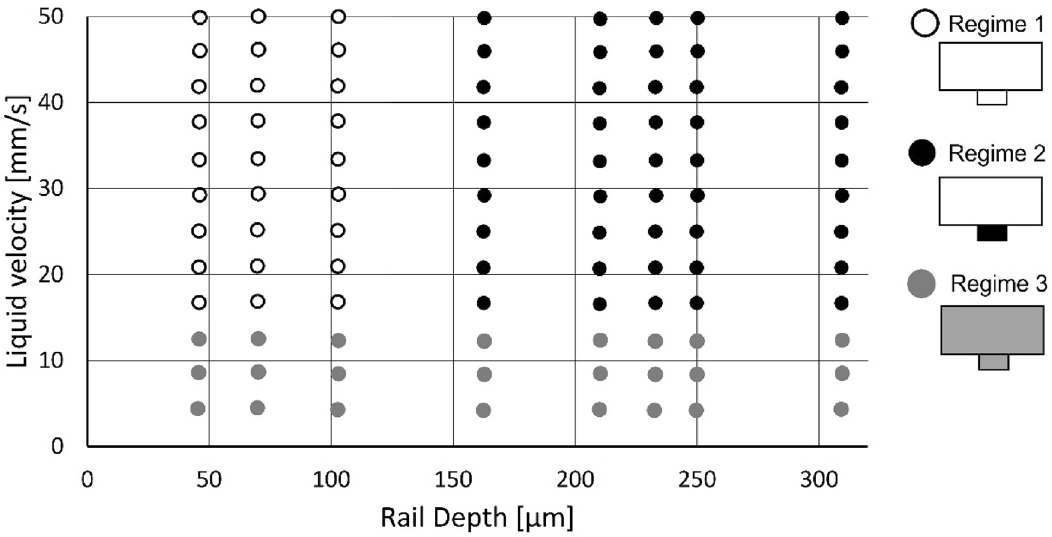
Figure 4. Map showing where the three regimes of liquid transport in a rail are observed as a function of rail depth and liquid flow